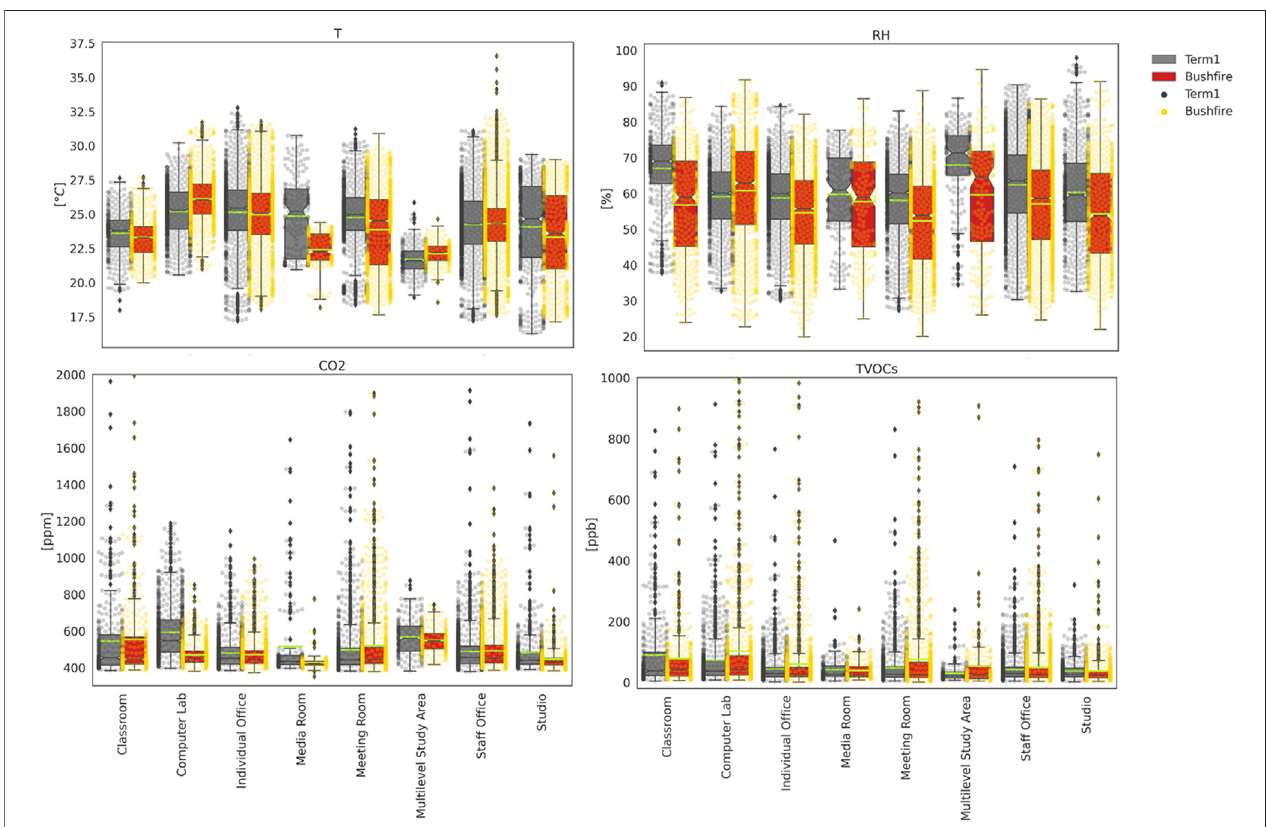
FIGURE 9 | IEQ behaviour across different room types: comparison between warm standard occupancy period and bush fi re. The y -axis limits are adjusted for a better visual comparison. Boxplots and overlapped swarmplots show mean observations, on hourly basis during occupied hours and workdays only.